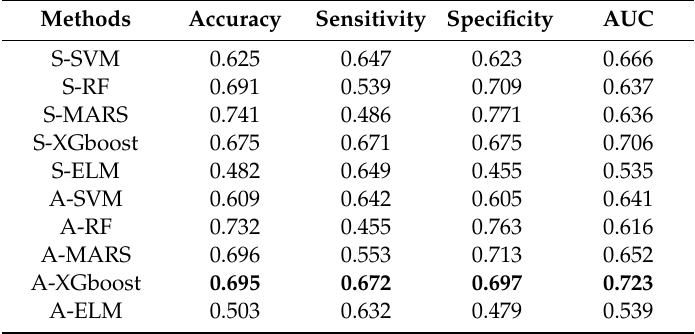
Table 5. Evaluation of the ten models based on the averaged classification